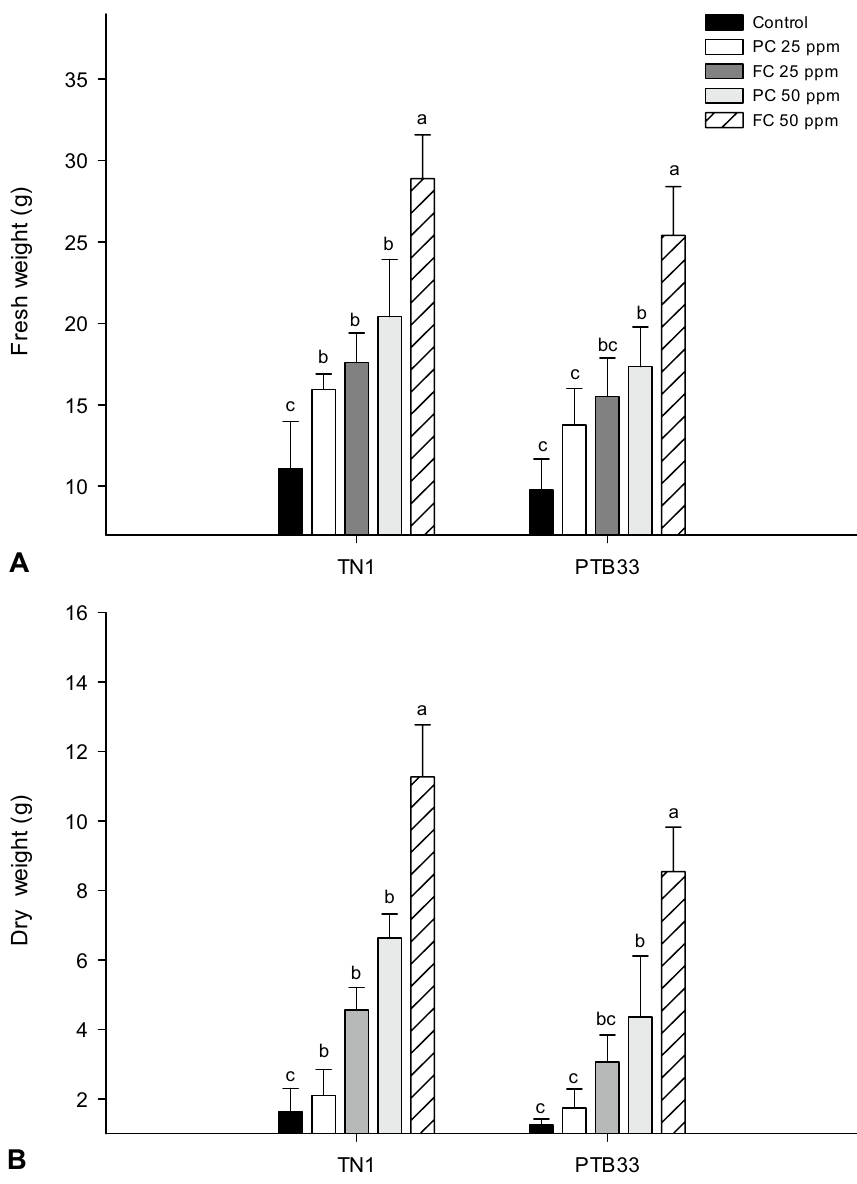
Figure 6. Fresh ( A ) and dry weight ( B ) of rice varieties after treatment with fungal (FC) and product chitosan (PC) (± SEM with five replication) (with in the bars denoted by a different letter are significantly different at P ≤